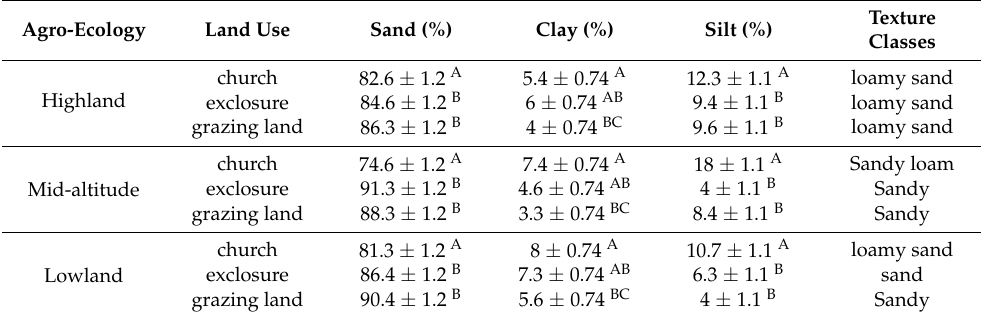
Table 7. Soil particle content of the study site ± Standard error of the mean (n = 9). (Values with different letter have significant difference and values with similar letter have no significant difference).